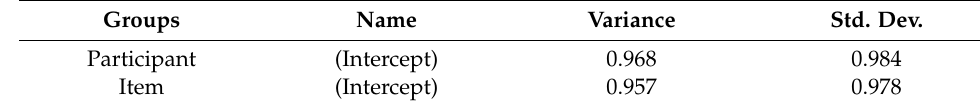
Table A11. Syrian Arabic T1 random effects.